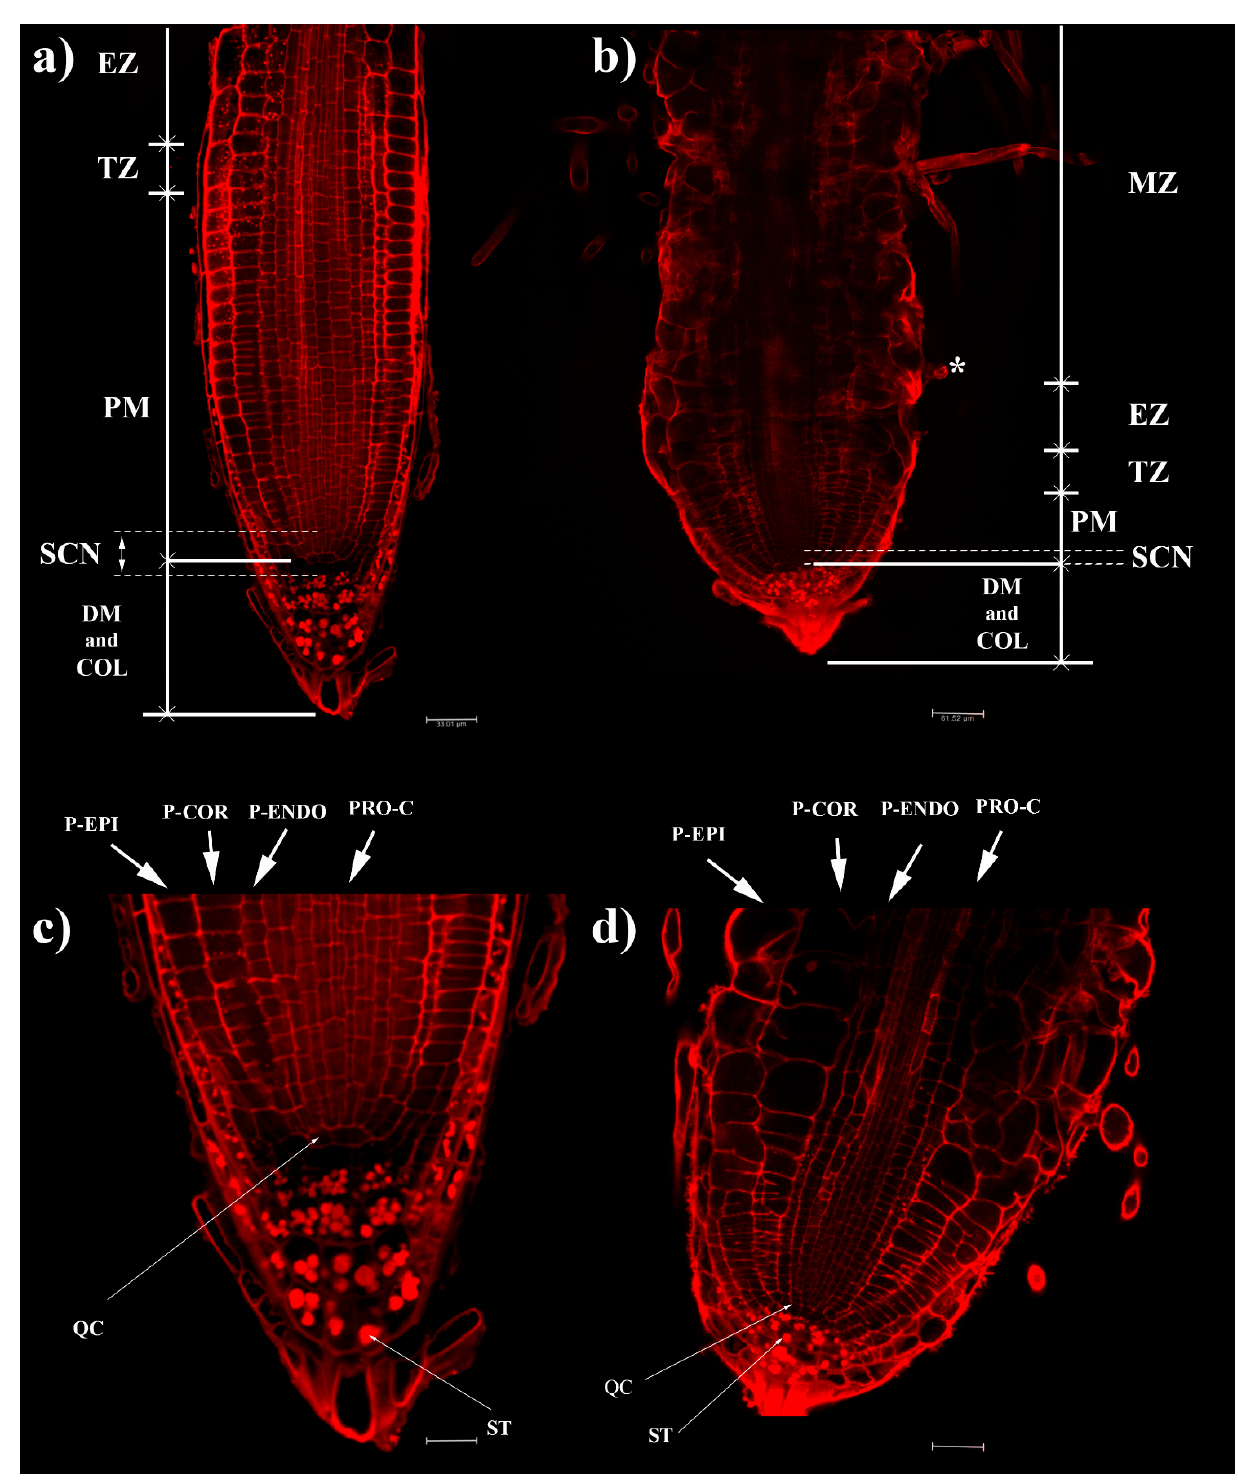
Figure 1. ( a – d ) Confocal laser microscope images of primary root tip, stained with propidium iodide, in 4 days old seedlings of A. thaliana treated for 7 days with coumarin 0 ( a , c ) and 100 µM ( b , d ). ( c , d ) Higher magnification of ( a , b ), respectively. Arabidosis RAM developmental zones: meristematic zone (MZ), the transition zone (TZ), and the elongation zone (EZ). The meristematic zone is divided into the distal meristem (DM) and the proximal meristem (PM). Moreover, in RAM, the stem cell niche (SCN) could be observed, as well as the quiescent center (QC), statoliths (ST), protodermis (P-EPI), precortex (P-COR), proendodermis (P-ENDO), and procambium (PRO-C); * first visible root hair. Scale bars: ( a ) 33.01; ( b ) 61.52; ( c ) 66.02; ( d ) 123.04 µm. N = 20.